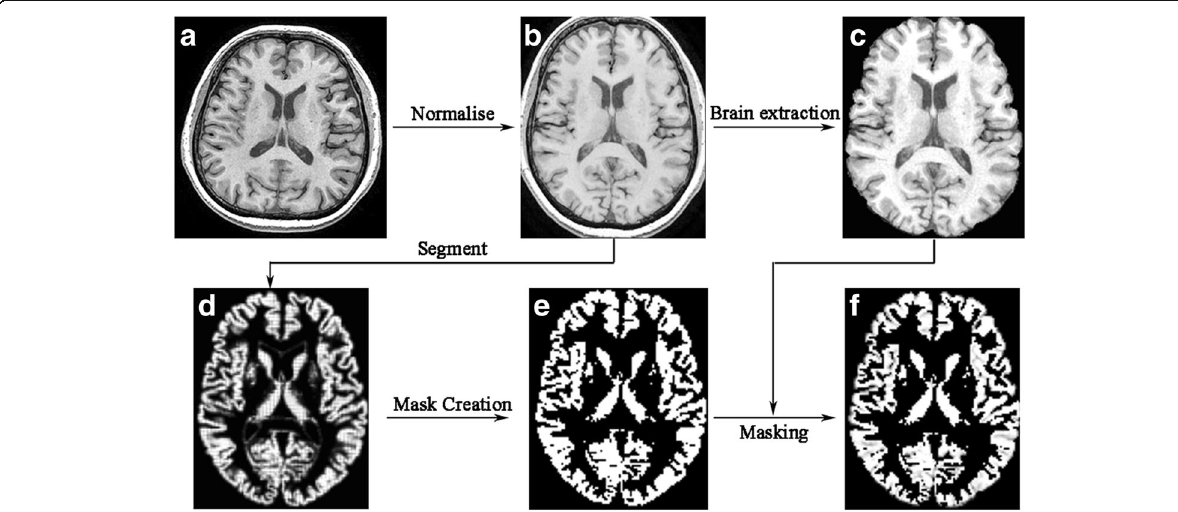
Fig. 1 The segments of gray matter in the brain including normalize, brain extraction, mask creation and masking to generate segmented gray matter. ( a ), raw T1 image; ( b ), normalized T1 image; ( c ), normalized T1 images without non-brain tissue; ( d ), gray matter probability images; ( e ), binary gray matter mask; ( f ), segmented gray